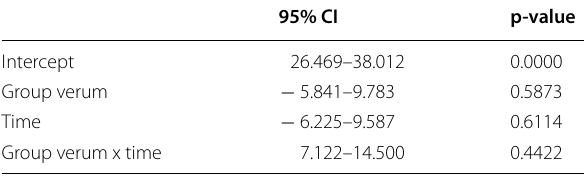
Table 8 Effect of group on SDNN, unadjusted